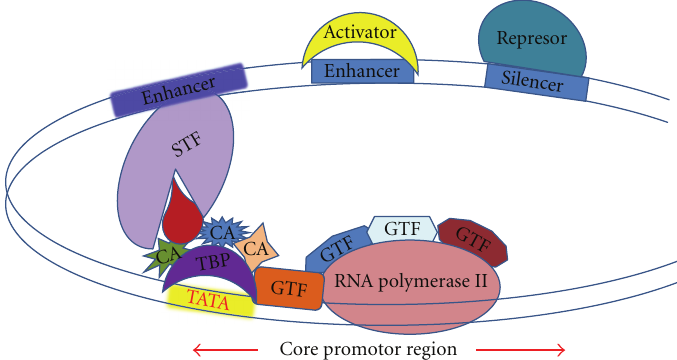
Figure 1: Representation of general transcription machinery: CA: coactivator, GTF: general transcription factor, STF: specific transcription factor, and TBP: TATA-binding